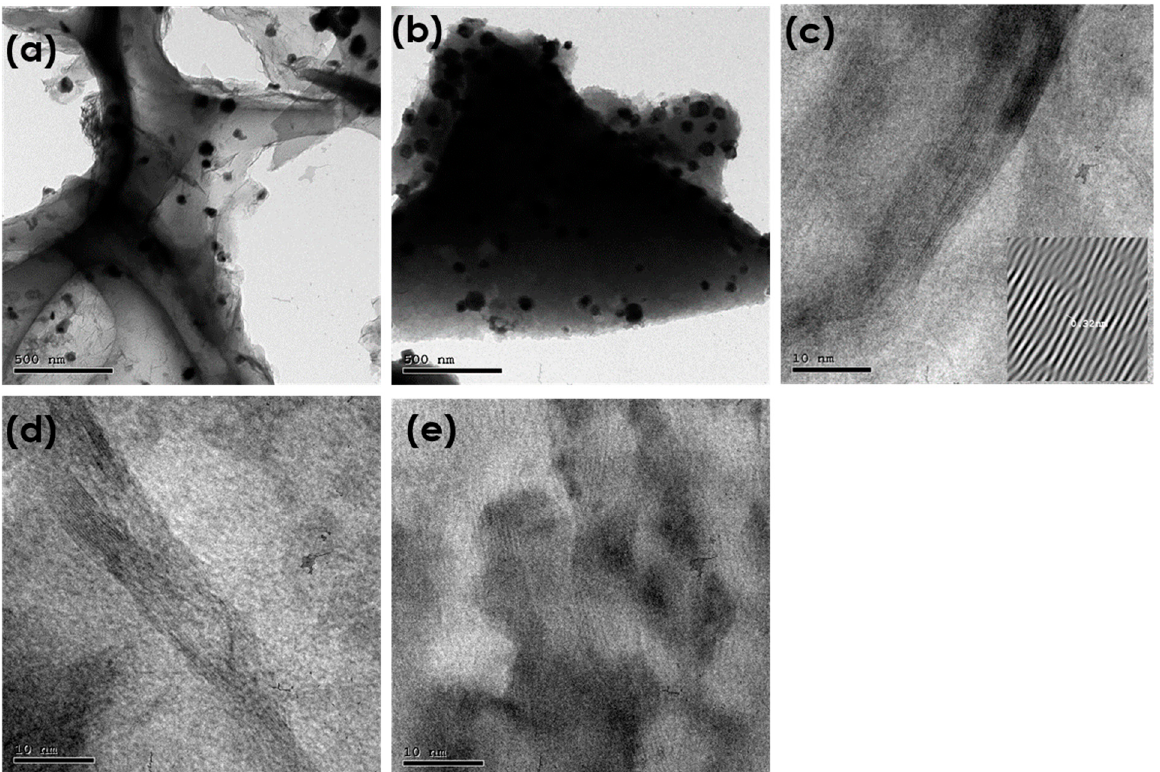
Figure 7. HRTEM images of ( a ) NiMo1/AC, ( b ) NiMo2/AC, ( c ) NiMo3/AC, ( d ) NiMo4/AC, and ( e ) NiMo5/AC.